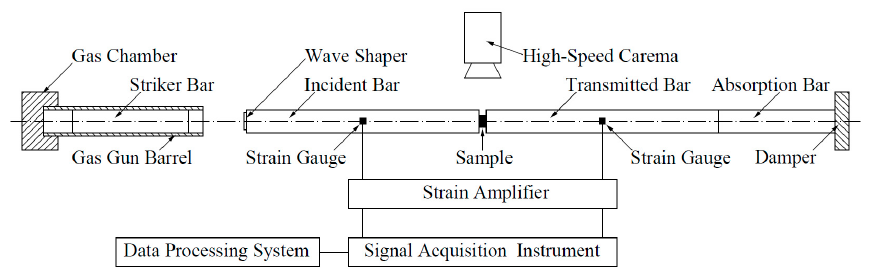
Figure 6. Schematic diagram of the SHPB test system.